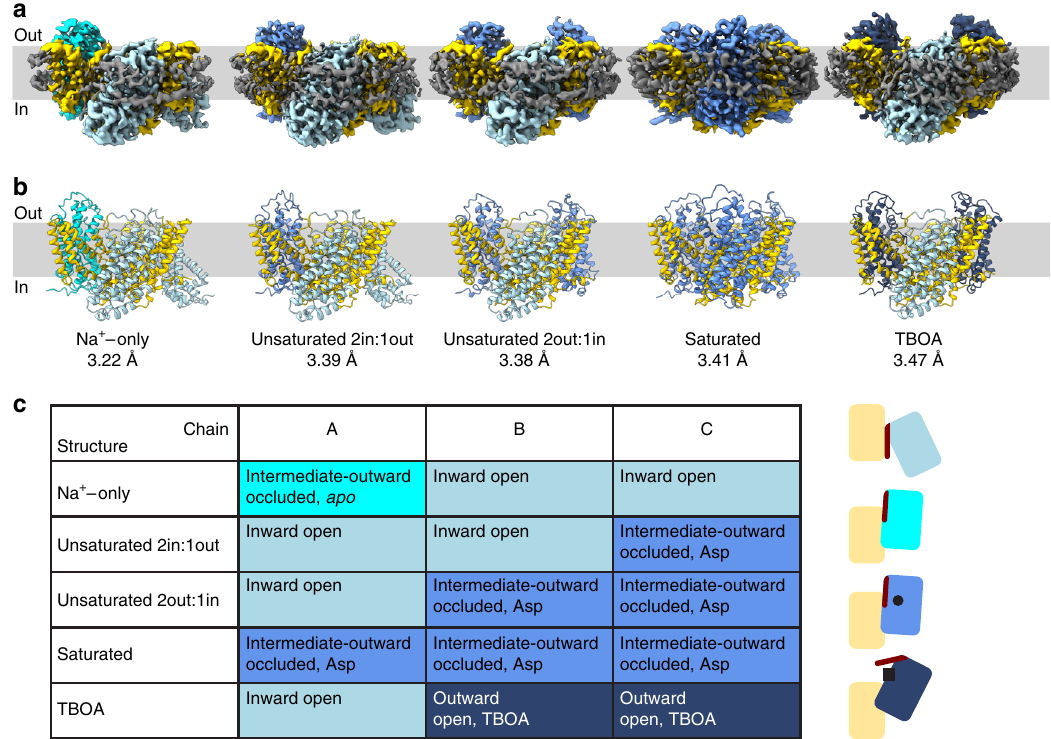
Fig. 1 Conformational states of the trimeric Glt Tk . a , b Volume and cartoon representation of fi ve cryo-EM structures of Glt Tk in MSP2N2 nanodiscs obtained in the absence of substrate (Na + -only), in presence of L-aspartate (unsaturated 2in:1out, unsaturated 1in:2out, saturated) or in the presence of DL-TBOA. The approximate position of the lipid bilayer is represented by the light gray bar, with indication of sides of the membrane ( in and out ). a The cryo-EM density for the MSP2N2 belt is shown in dark gray. The transport domains of the individual protomers are present in four different conformations: inward open (steel blue), intermediate-outward occluded apo (cyan), intermediate-outward occluded Asp (corn fl ower blue), outward-open TBOA (dark blue). The scaffold domains are shown in yellow. c Table summarizing conformations of Glt Tk protomers. Schematic representation of the conformations on the right in the same colors as in a , b , with indication of L -aspartate (black circle), DL-TBOA (black square) and HP2 (dark red stick).